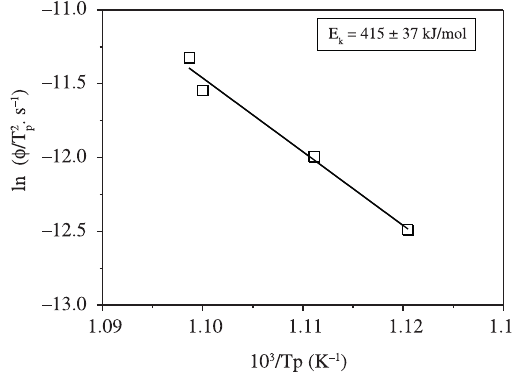
Figure 5. Plot of ln( φ /T p2 ) versus 1/T Kissinger’s method.